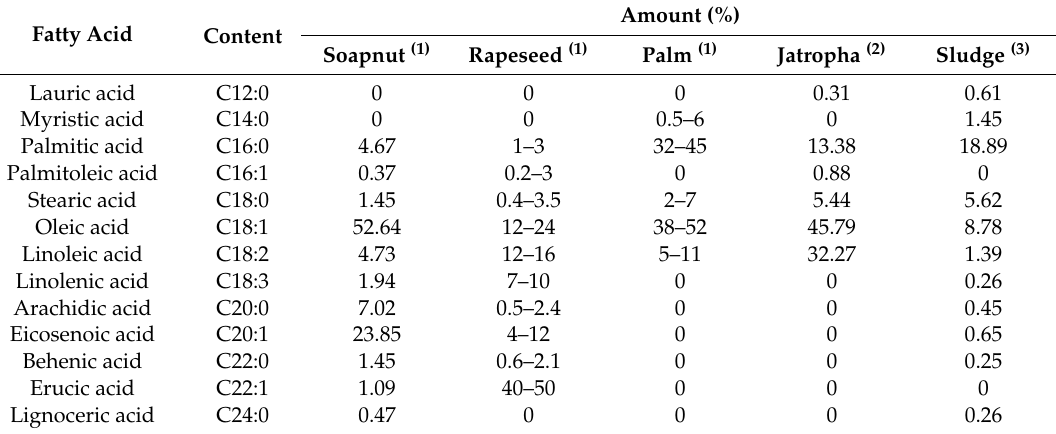
Figure 6. GC-MS chromatograms of the analysis data of the biodiesel from the extracted lipids of sludge. Table 2. FAME compositions of the vegetable oil and sludge-derived biodiesel.